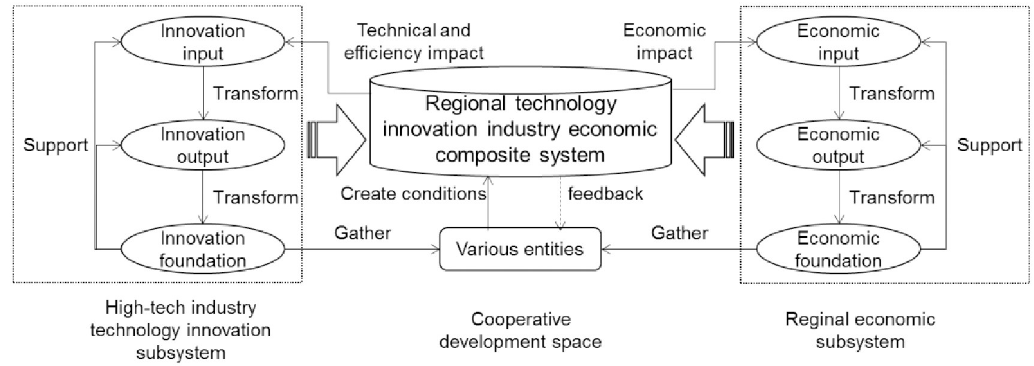
Fig 3. Mechanism of synergistic evolution of technological innovation and regional economic composite